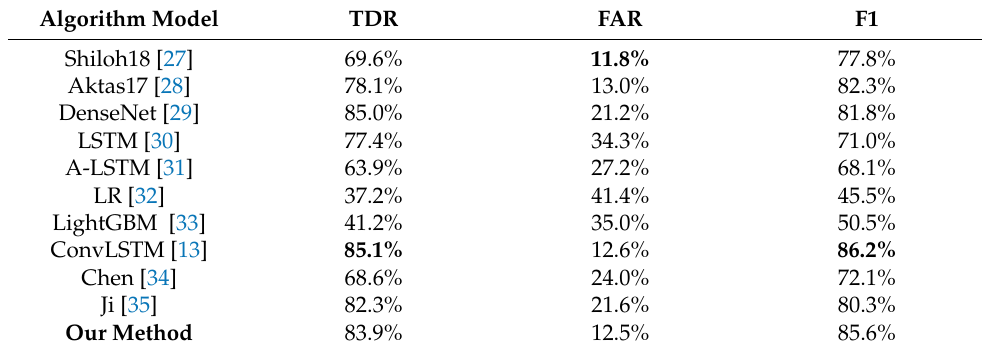
Table 6. Comparison of anomaly detection